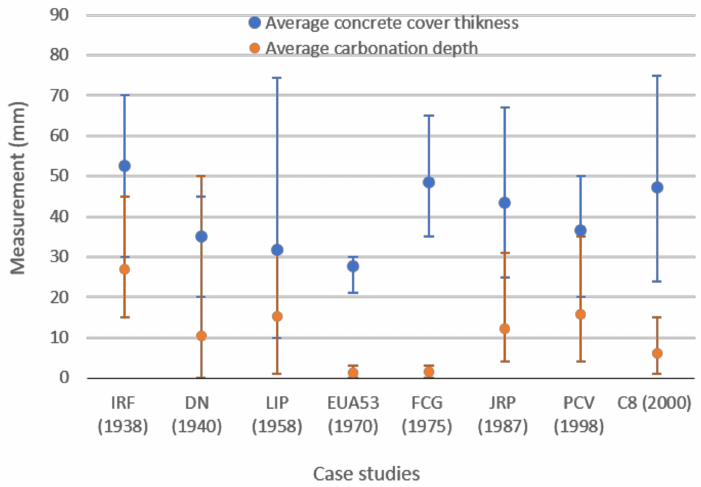
Figure 6. Relationship between concrete cover thickness and the carbonation depth in NAC sampling zones. Range of results: minimum to maximum.